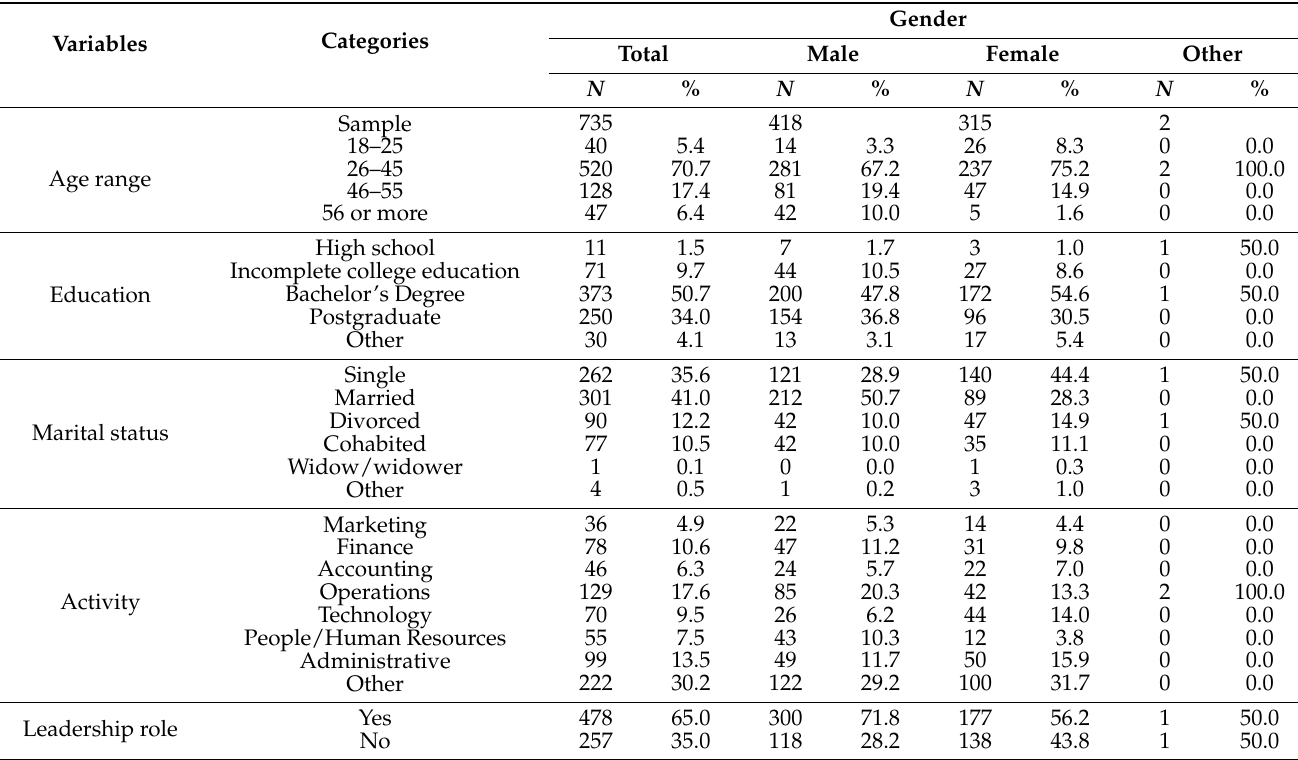
Table 1. Participant’s profile who answered T1 ( N =